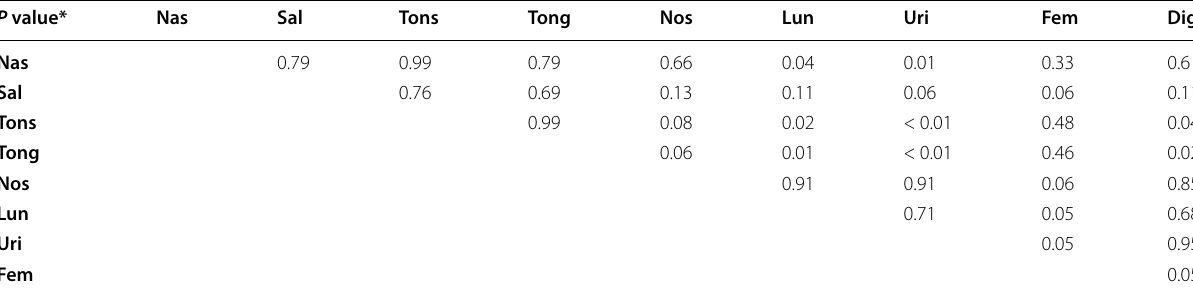
Table 3 Pairwise comparisons of regional LELC survival in the nine sites